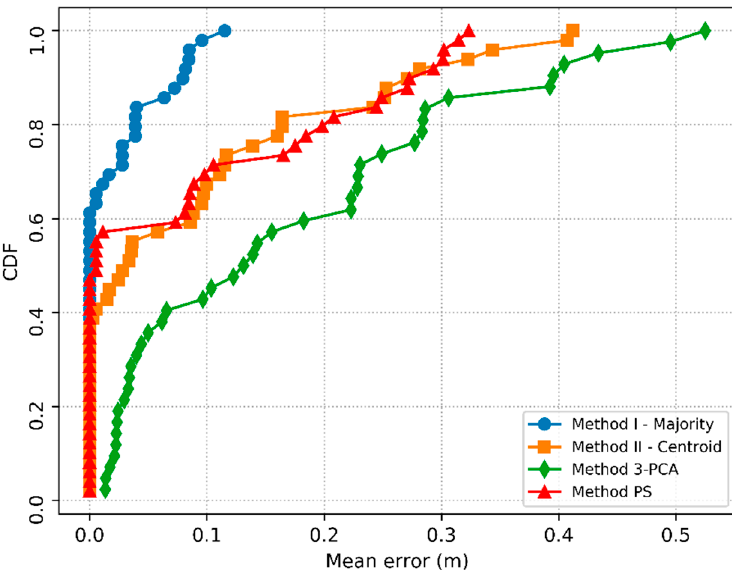
Figure 7. Cumulative distribution function (CDF) for localization errors.